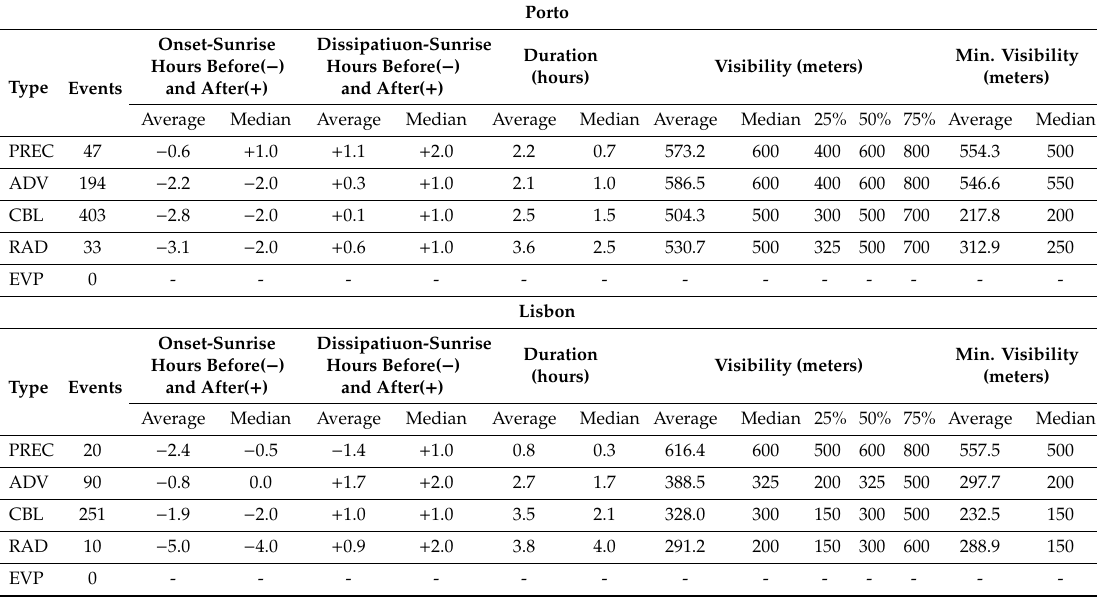
Table 4. Porto and Lisbon types of fog events: onset and dissipation o ff set, duration, fog events visibility and minimum